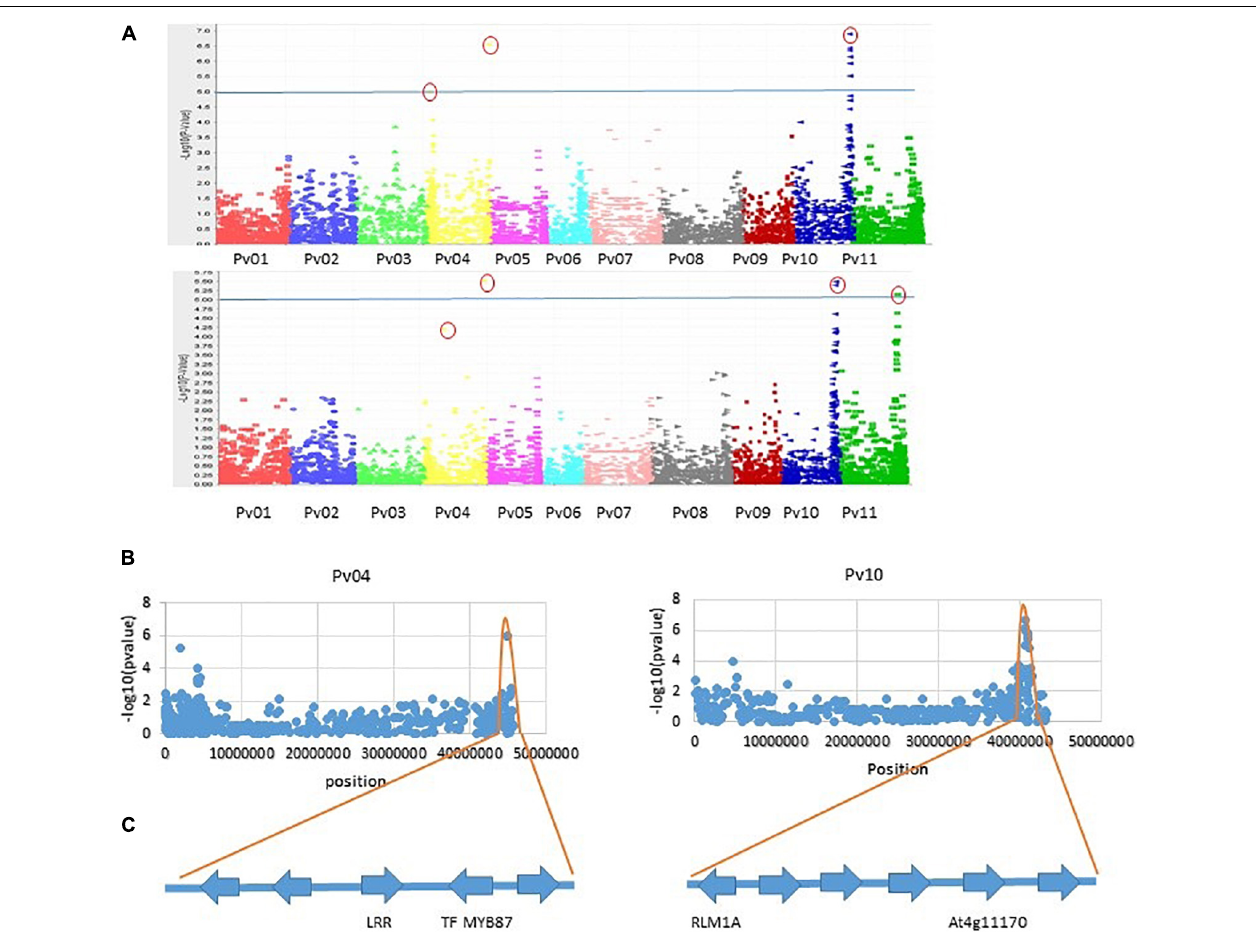
FIGURE 5 | (A) Manhattan plots of two seasons for PM disease in 206 collections of bean genotypes using 5052 SNP markers. The horizontal line is the cutoff for significance, and a small red round indicated the most significant markers. (B) Distribution of SNPs on Pv04 and Pv10 and the range of SNP peaks. (C) Four putative genes identified based on the most significant SNPs and the highest contribution to phenotypic